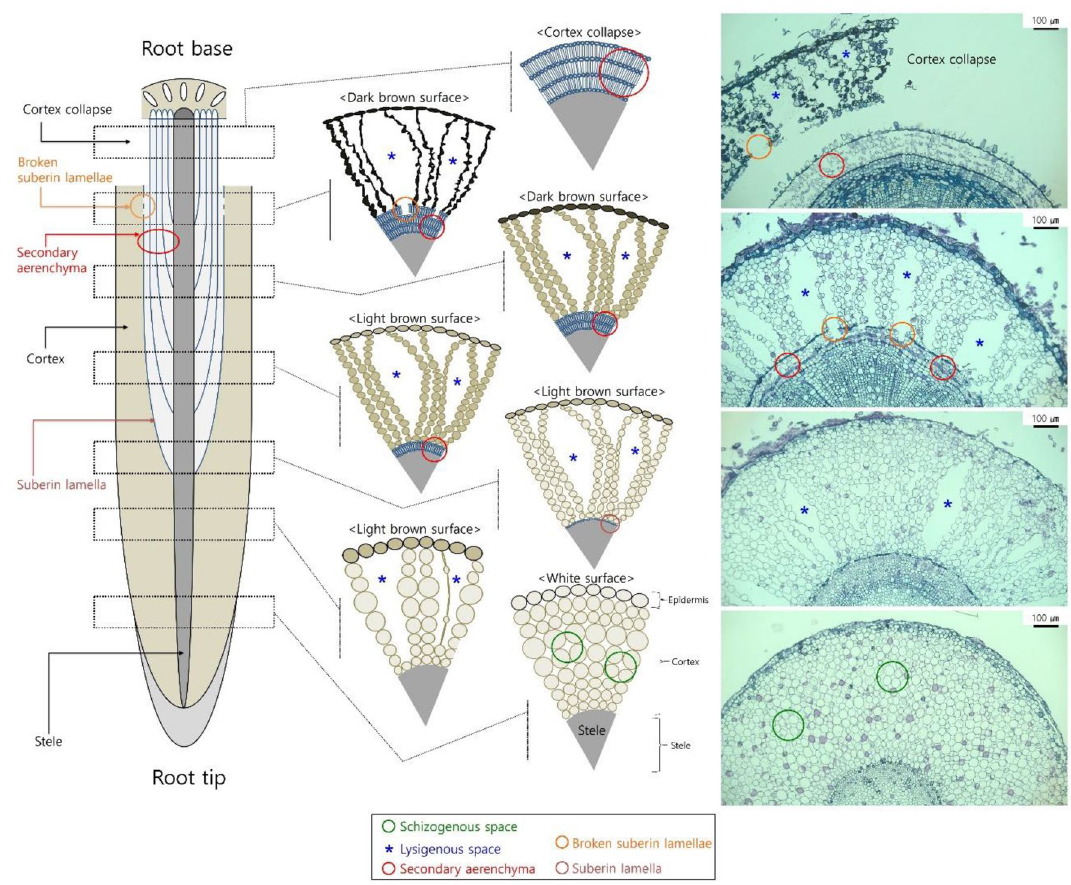
Figure 6. Diagram of the primary and secondary aerenchyma development sequence along the S. kunstleri adventitious roots grown in agar media for 150 days. Primary aerenchyma is root cortex tissue with large intercellular spaces. Primary aerenchyma forms through two distinct development processes: separation of cells (schizogenous aerenchyma) or cell death (lysigenous aerenchyma). Schizogenous aerenchyma develops only near the root tip. Lysigenous aerenchyma develops in the middle part and near the root base. Secondary aerenchyma differentiates from the phellogen, cambium, and pericycle of stems or roots. Secondary aerenchyma is composed of suberin lamellae and begins to develop inside the lysigenous aerenchyma. Secondary aerenchyma develops after the primary aerenchyma has